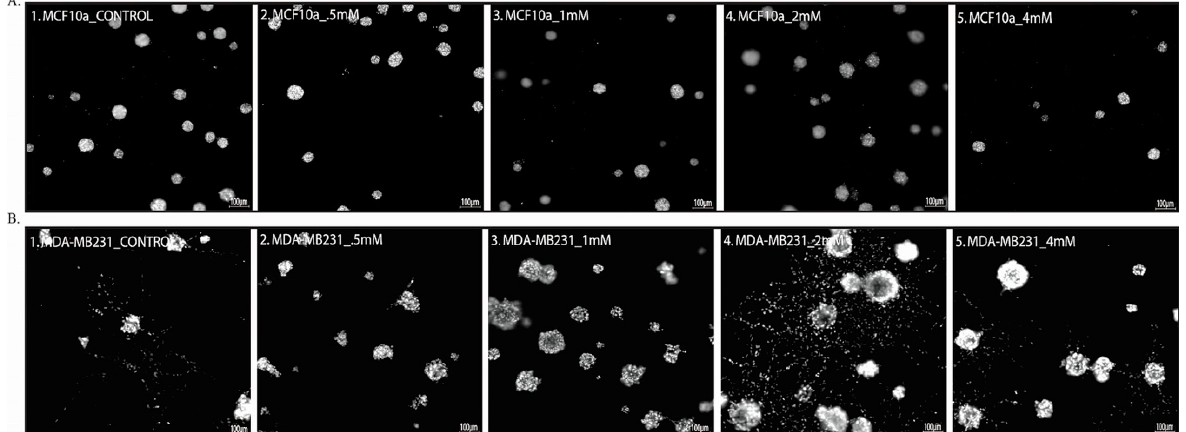
Figure 3. Morphological aspects of 3D matrigel culture. ( A ) Normal mammary epithelial cells MCF10A; ( B ) human breast adenocarcinoma cell line MDA-MB231; (1. Untreated; 2–5 treated with 0.5 mM, 1 mM, 2 mM, and 4 mM sevoflurane). n = 2.